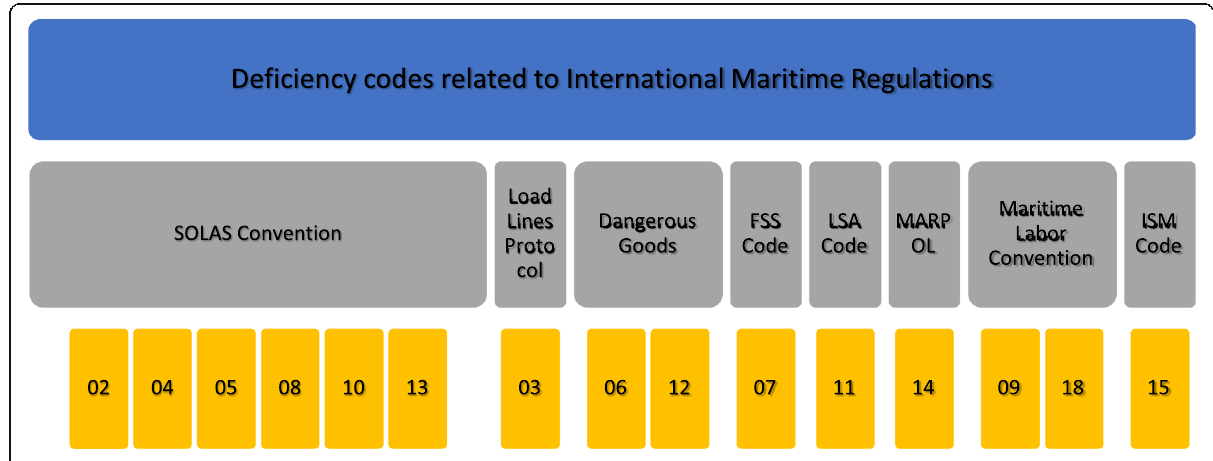
Fig. 2 The hierarchical structure of deficiency codes related to International Maritime